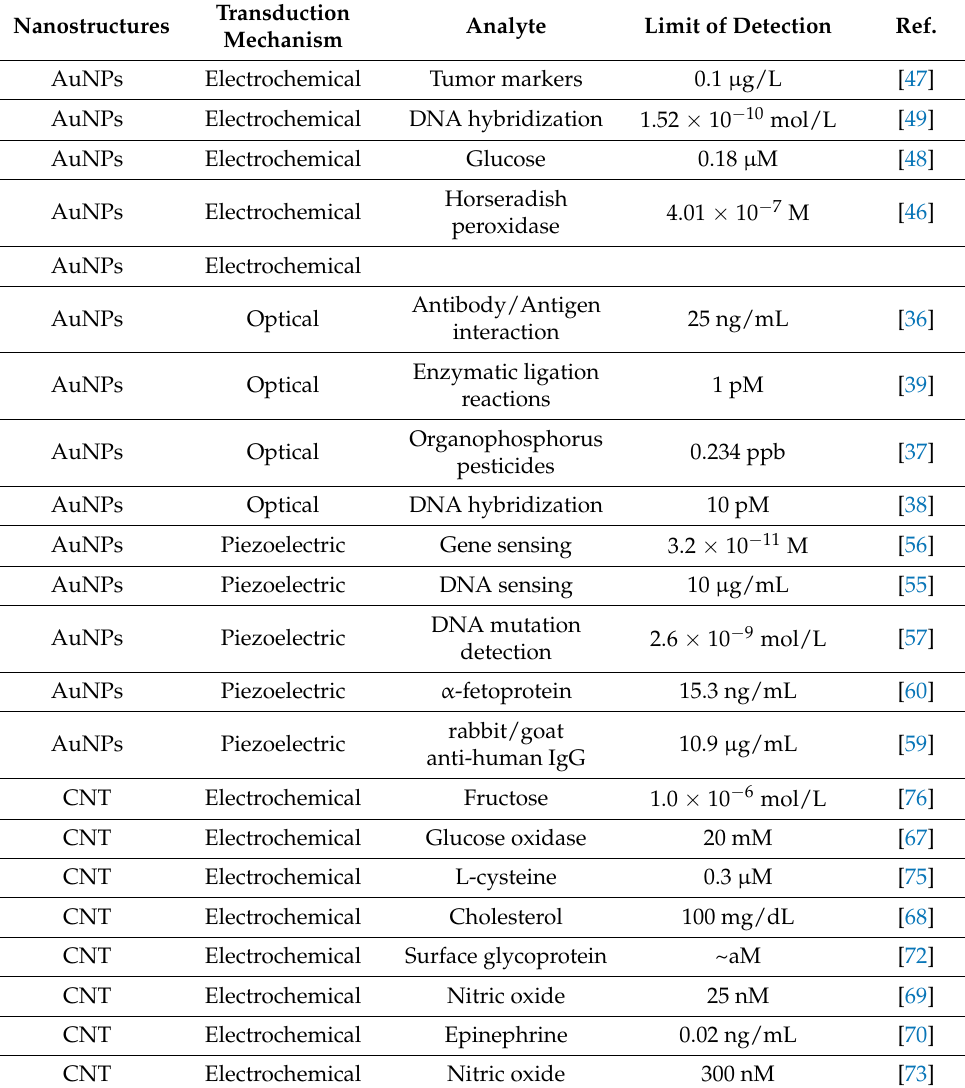
Table 1. The different nanostructures utilized for biosensing, along with their transduction technique as well as the limit of